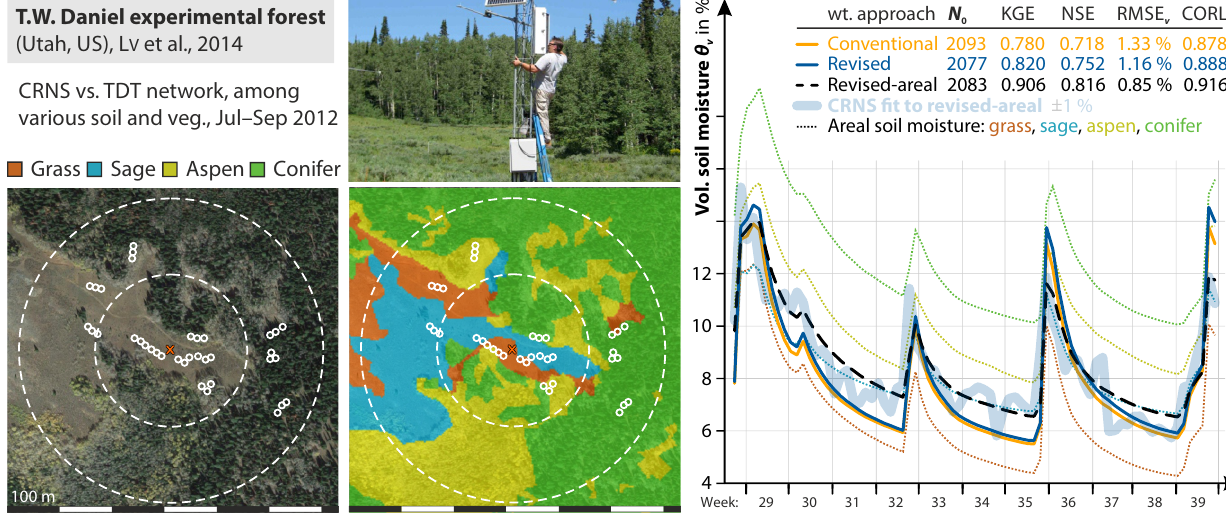
Figure 10. Time series of CRNS and TDT soil moisture at the T. W. Daniel Experimental Forest . The area was split into four categories (dotted lines), to which the corresponding soil moisture measurements were assigned. The areal coverage was then averaged (dashed line) pixel by pixel (1m resolution) with the revised weighting approach, leading to the best performance against the CRNS